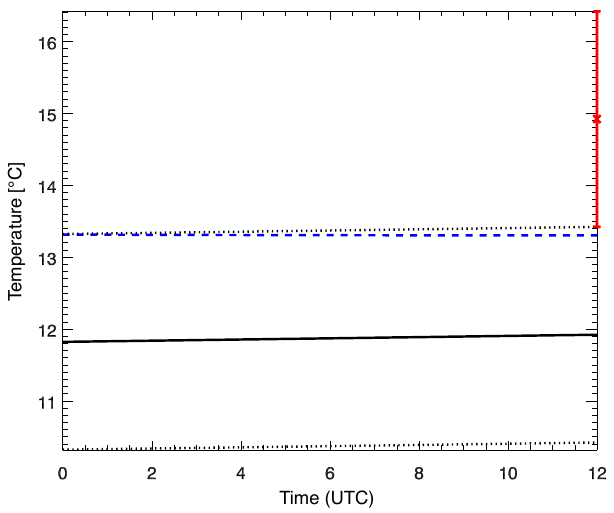
Figure 2. Assimilation of a virtual soil temperature observation in soil level 9 (172cm depth) at the end of an assimilation interval of 12h. The black curve shows the background result, the dotted black lines indicate the background error, and the blue dashed line shows the analysis. The observation is displayed in red.